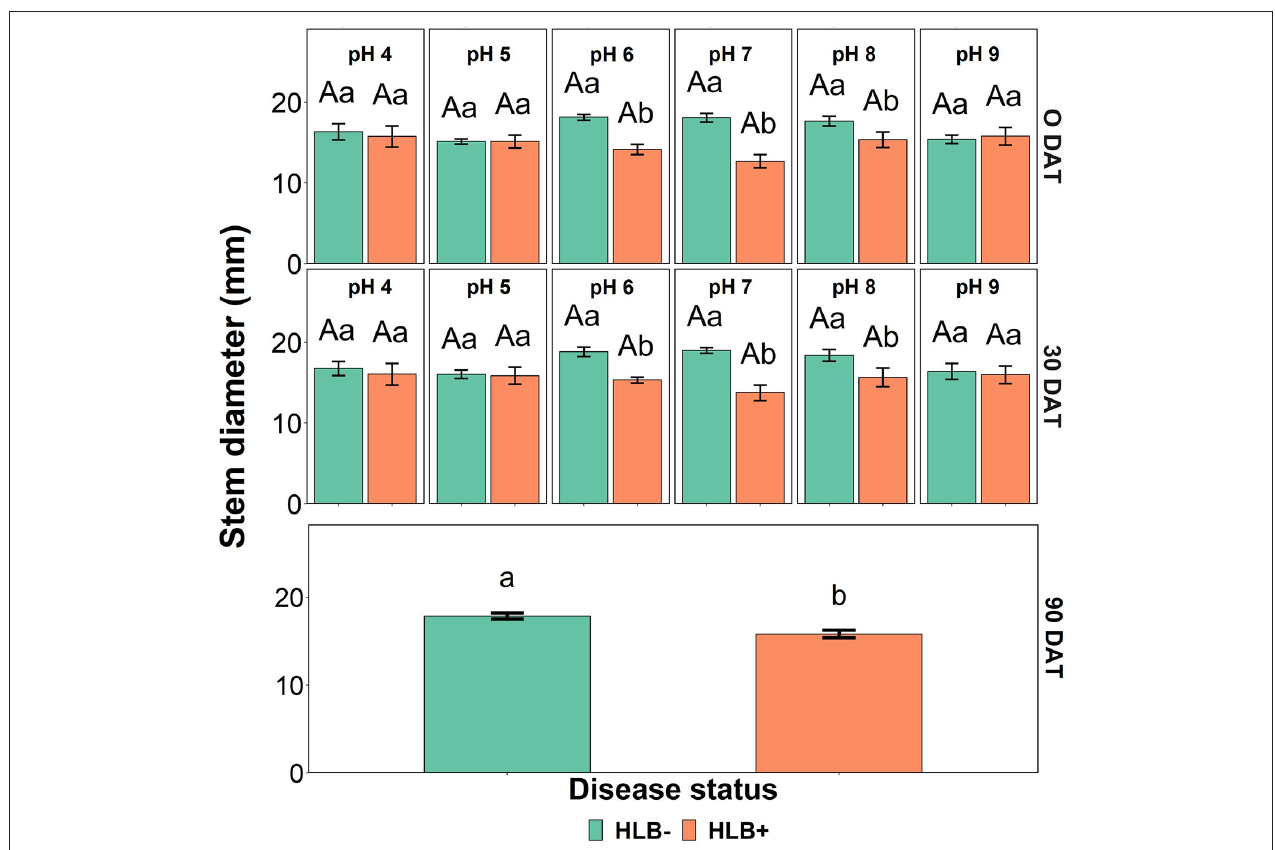
FIGURE 6 | Stem diameter interactions of “Ray Ruby” grapefruit ( C. paradisi ) on sour orange ( C. aurantium ) rootstock exposed to different HLB disease statuses [HLB-free or healthy (negative, HLB–) and HLB-affected (positive, HLB + )] under an increasing range of substrate pHs (4–9) at 0, 30, and 90 DAT. Means ± standard error ( n = 4) followed by the same letters are not different by Tukey honest significant difference (HSD, α = 0.05). Means with the same uppercase letters are not different on each substrate pH within disease status and means with the same lowercase letters are not different within the disease status per substrate